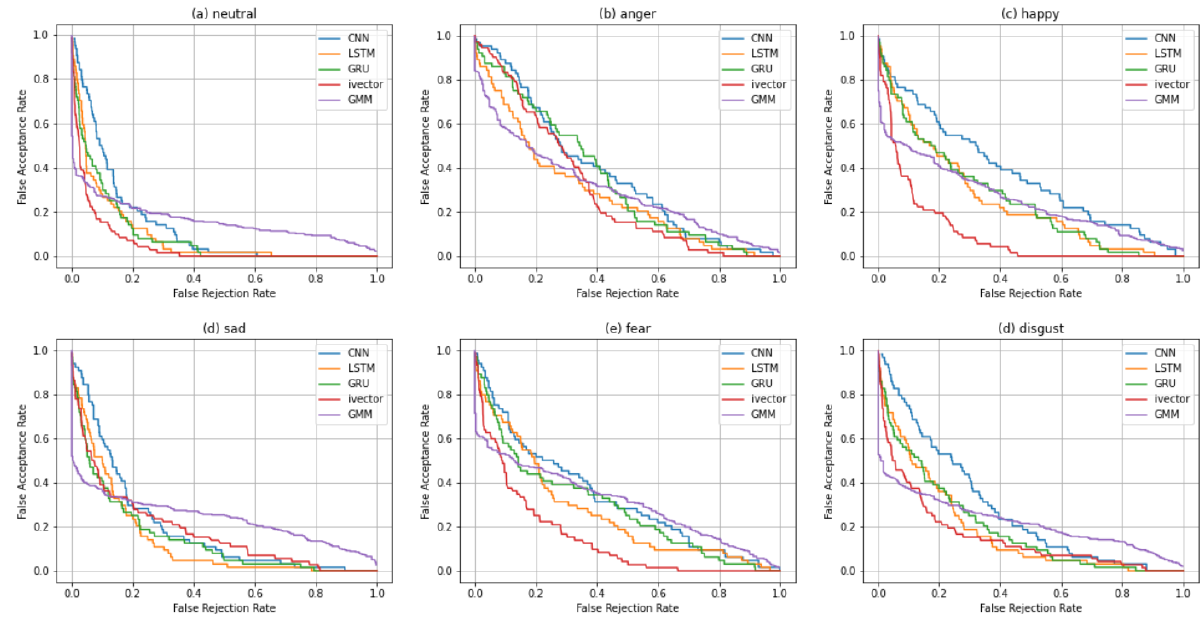
Figure 9. DET curves with each based on CNN, LSTM, GRU, i vector, and GMM models for the different emotional states using the CREMA database. Table 5. p -value using Wilcoxon test for classical and deep models using the CREMA database.